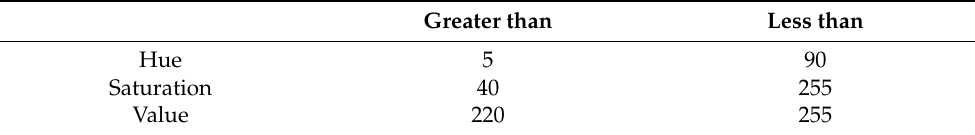
Table 1. Color range of flame pixels in HSV color model.